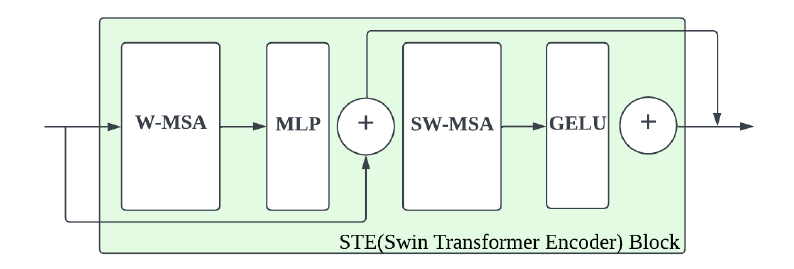
Figure 2. Swin Transformer Module.